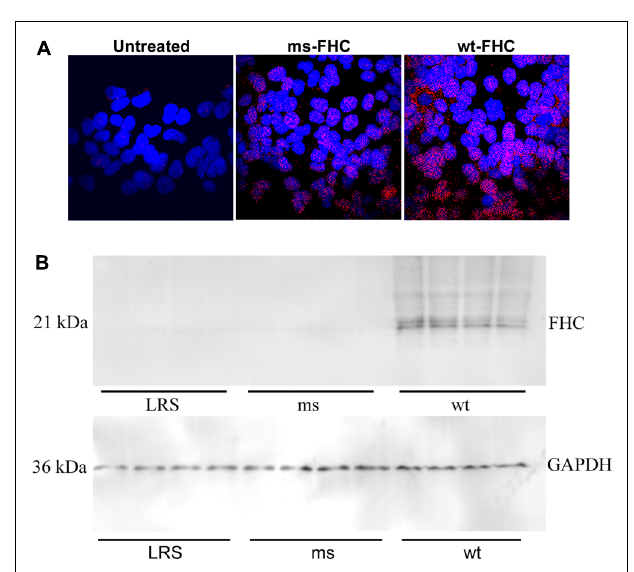
FIGURE 6 | Human FHC is expressed in the nuclei of mice expressing wt- and ms-FHC. (A) Immunofluorescence for human FHC (red) in HEK-293 cells untreated or transfected with wt-FHC or ms-FHC constructs. Nuclei were stained with DAPI (blue). (B) Nuclear extracts from the livers of LRS-, ms-, and wt-FHC treated mice ( n = 4) were isolated; 30 μ g of nuclear extract protein from each liver was run on western blot and immunostained for human FHC. Note: different primary antibodies to FHC were used for (A) and (B) .